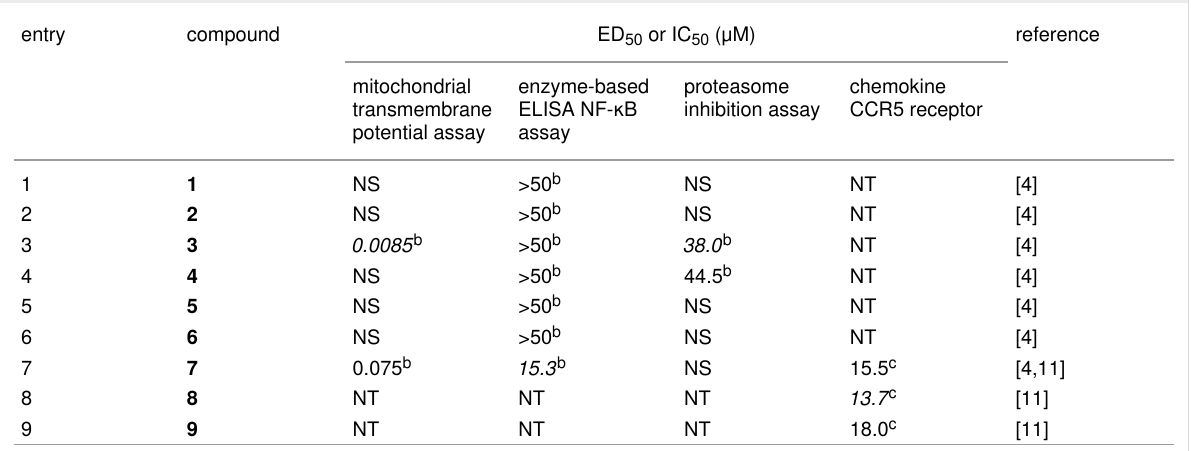
Table 2: Summary of other biological evaluations for brevipolides A–I ( 1 – 9 ) found in the literature.